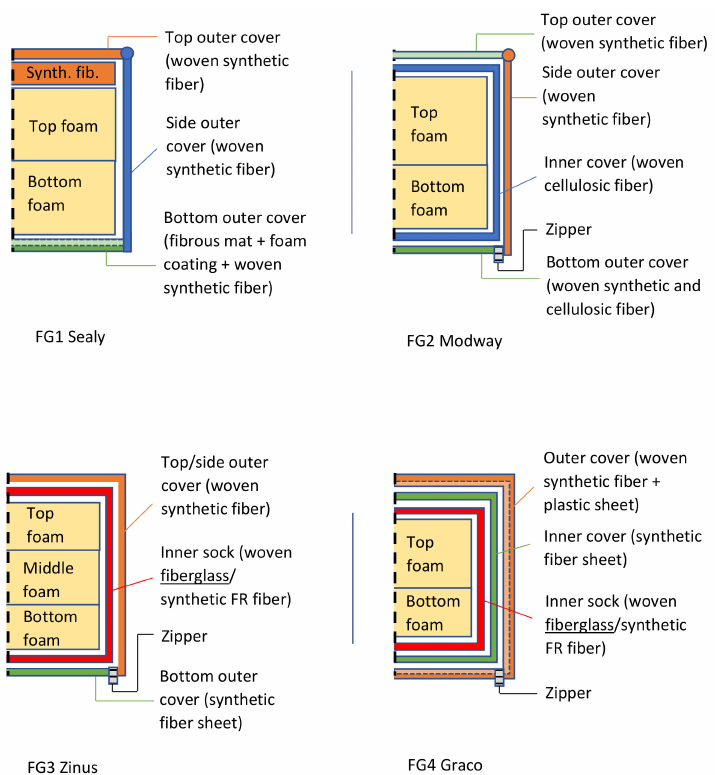
Figure 1. Main components of each tested mattress and observed compositions.